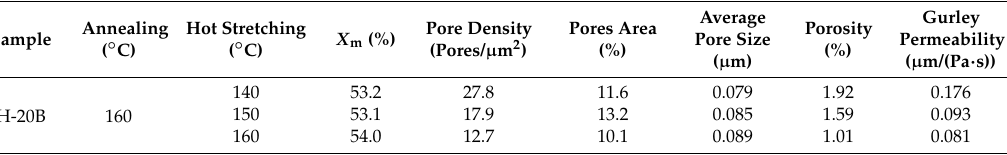
Figure 6. SEM micrographs of sample H-20B. Precursor films annealed at 160 °C and stretched at three different temperatures during the second uniaxial stretching step. Table 5. Characteristics of membranes prepared at different temperatures during the second stretching step in terms of membrane crystallinity, pore morphology , and air permeability.